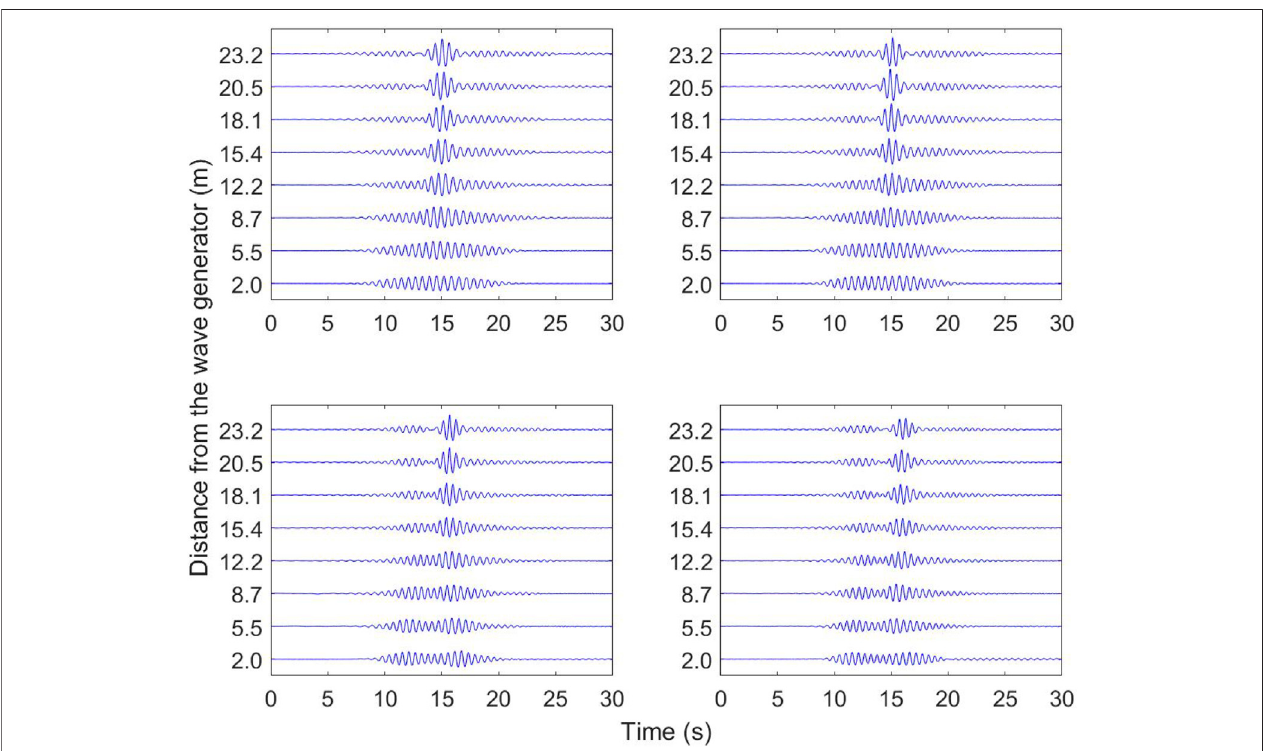
FIGURE4| Experimentalobservationofadegeneratesolitonfor a (cid:2) 0.01mand x p (cid:2)− 23mwithvaryingsteepnessvaluesasmeasuredintheUniversityofSydney fl ume. Top left : ka (cid:2) 0.10. Top right : ka (cid:2) 0.11. Bottom left : ka (cid:2) 0.12. Bottom right : ka (cid:2) 0.13.